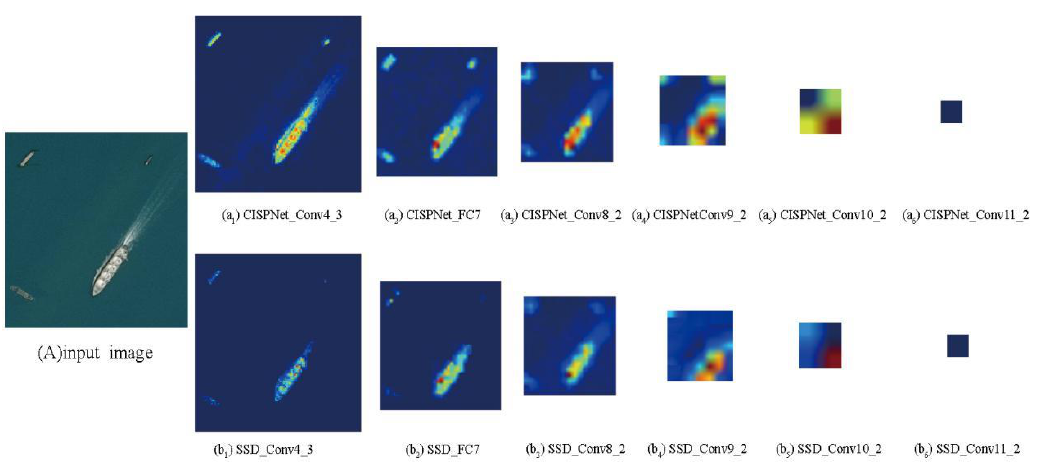
Figure 4. CISPNet and SSD illustrate the image and its corresponding multi-scale feature map; ( a 1 )–( a 6 ) are the characteristic maps of the FaSSD output at the multi-scale feature layer; ( b 1 )–( b 6 ) are the characteristic maps of the SSD output at the multi-scale feature layer.